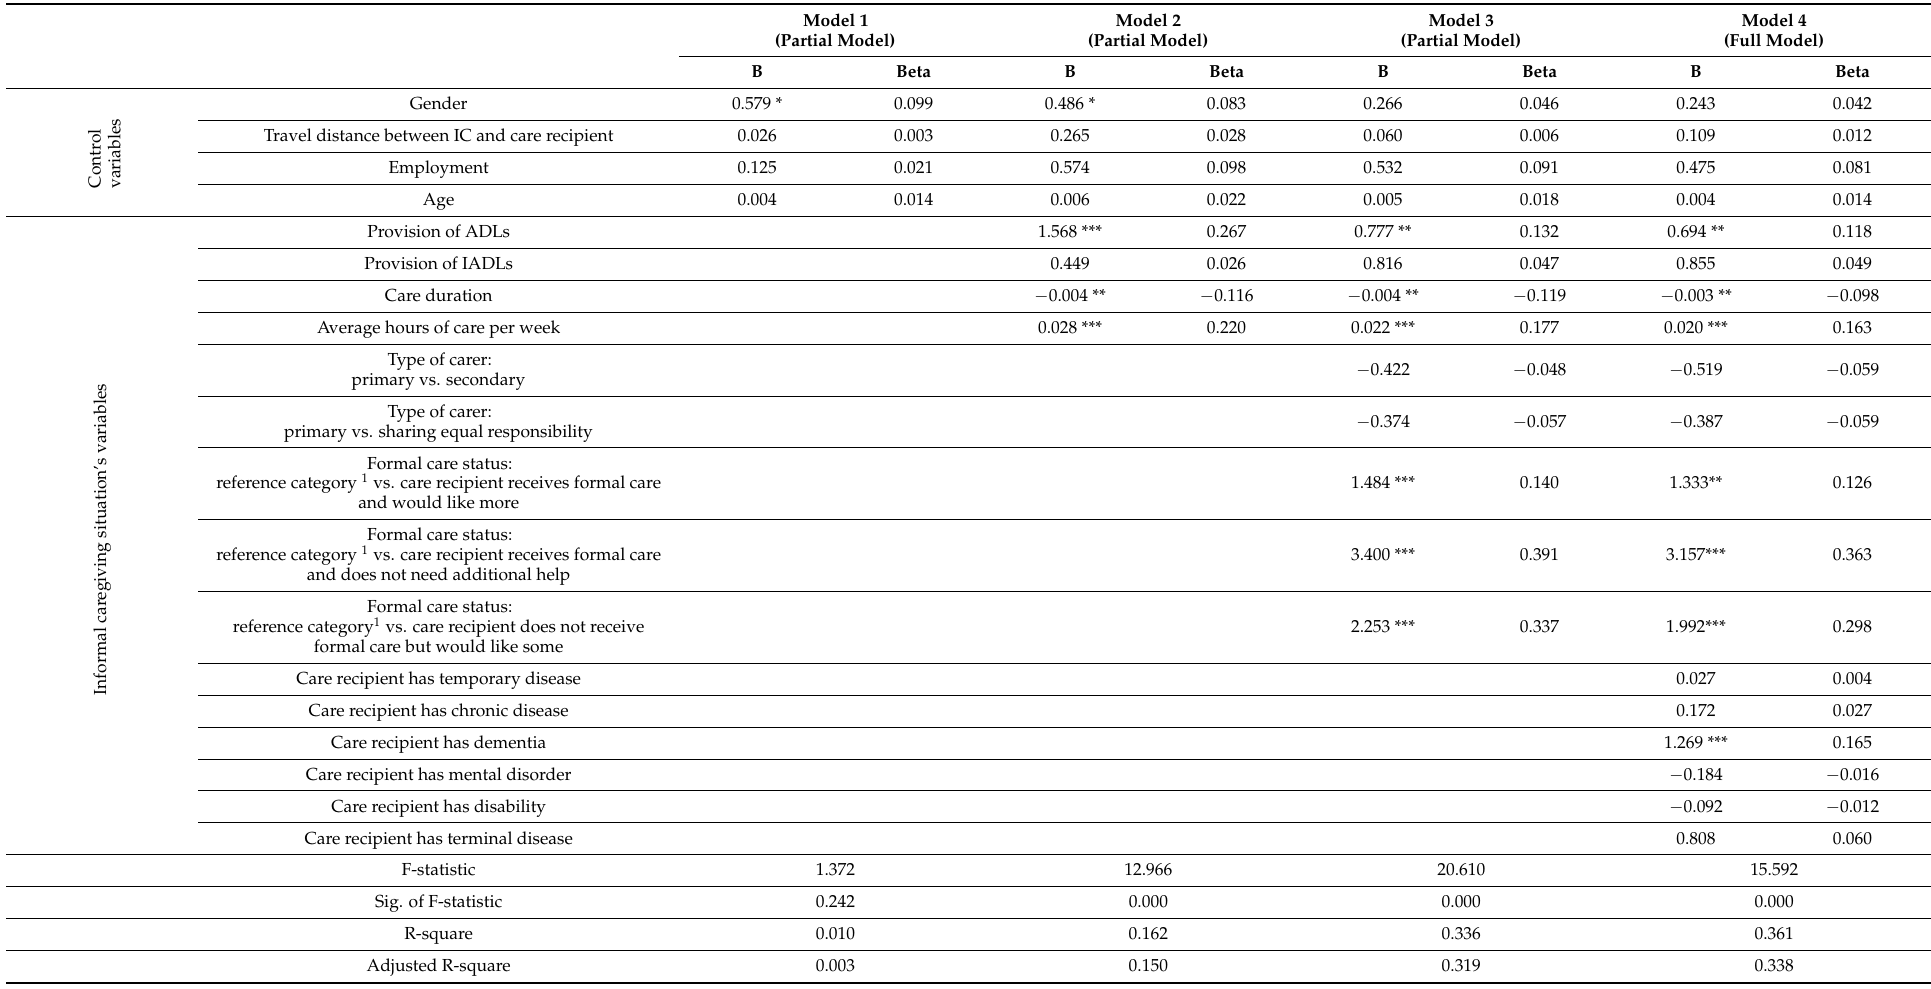
Table 4. Multiple regression analyses predicting ICs’ subjective burden during